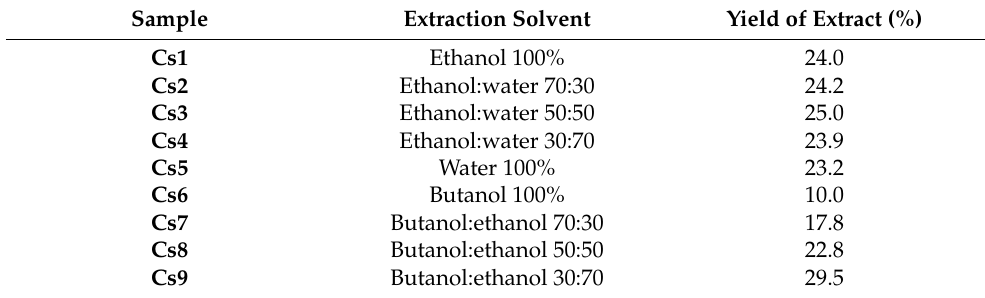
Table 1. C. spicatum extract used in this